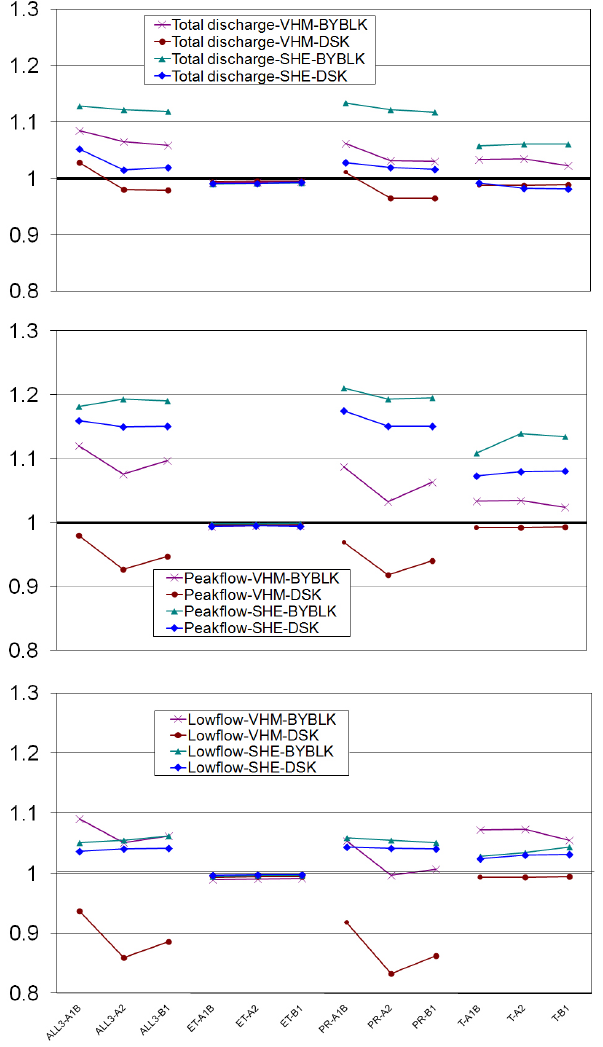
Fig. 16. Mean level of impact results on mean, peak, and low flows at BYBLK and DSK gauging stations after VHM and MIKE- SHE simulations (after changes to all or individual hydro-climatic variables).